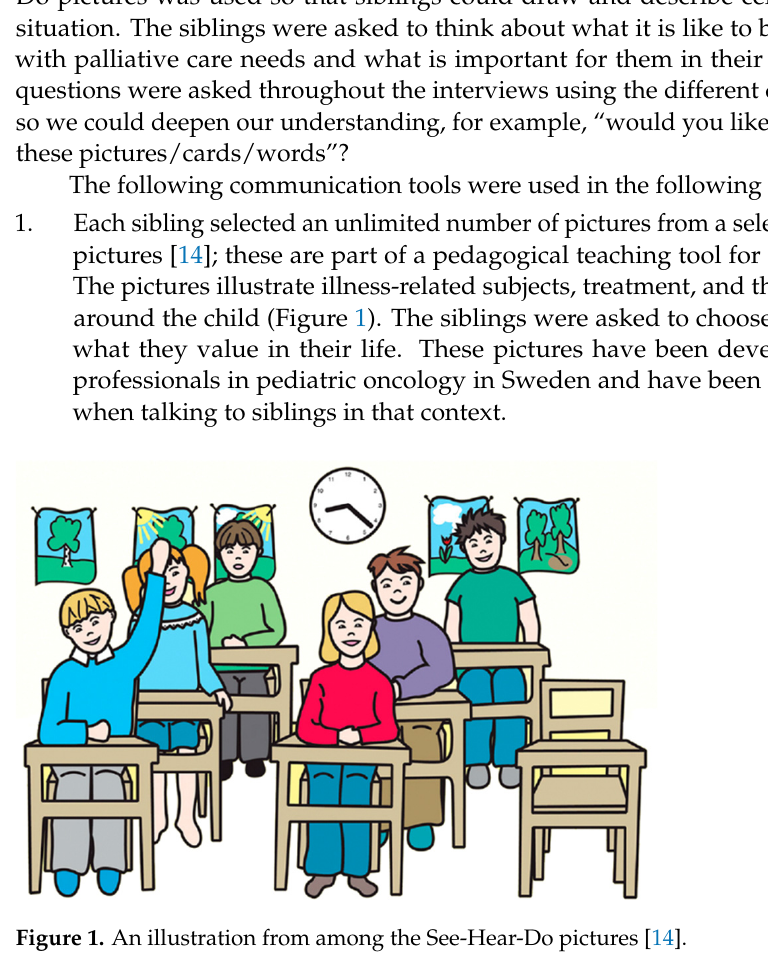
Figure 1. An illustration from among the See-Hear-Do pictures